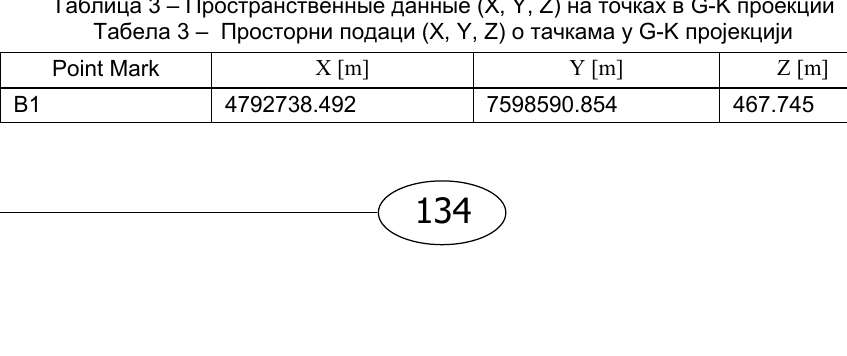
Table 3 – Spatial data (X, Y, Z) on the points in the G-K